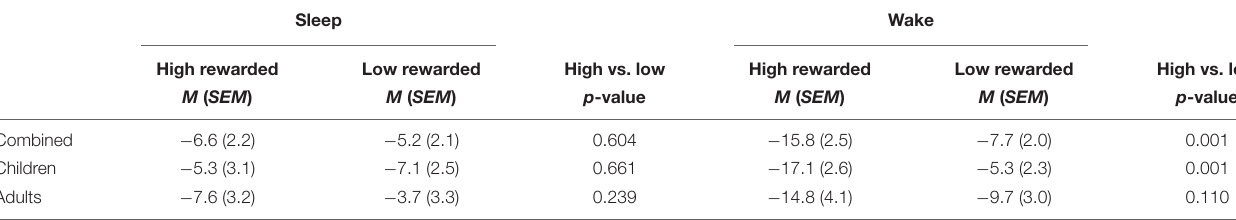
TABLE 2 | Memory performance.